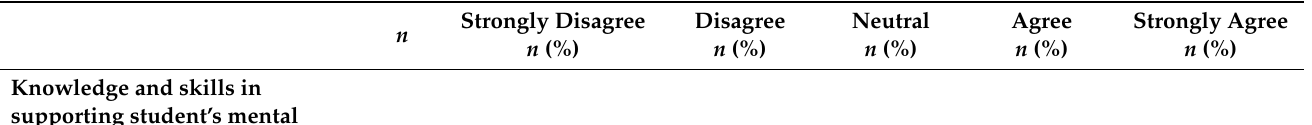
Table 3. School nurses’ knowledge and skills for supporting student mental health and their perceptions of teachers’ involvement in addressing mental health needs of the